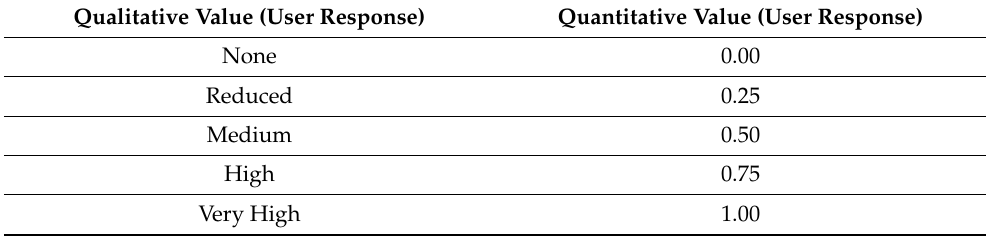
Table 5. Scale defined for the objective function coefficients.